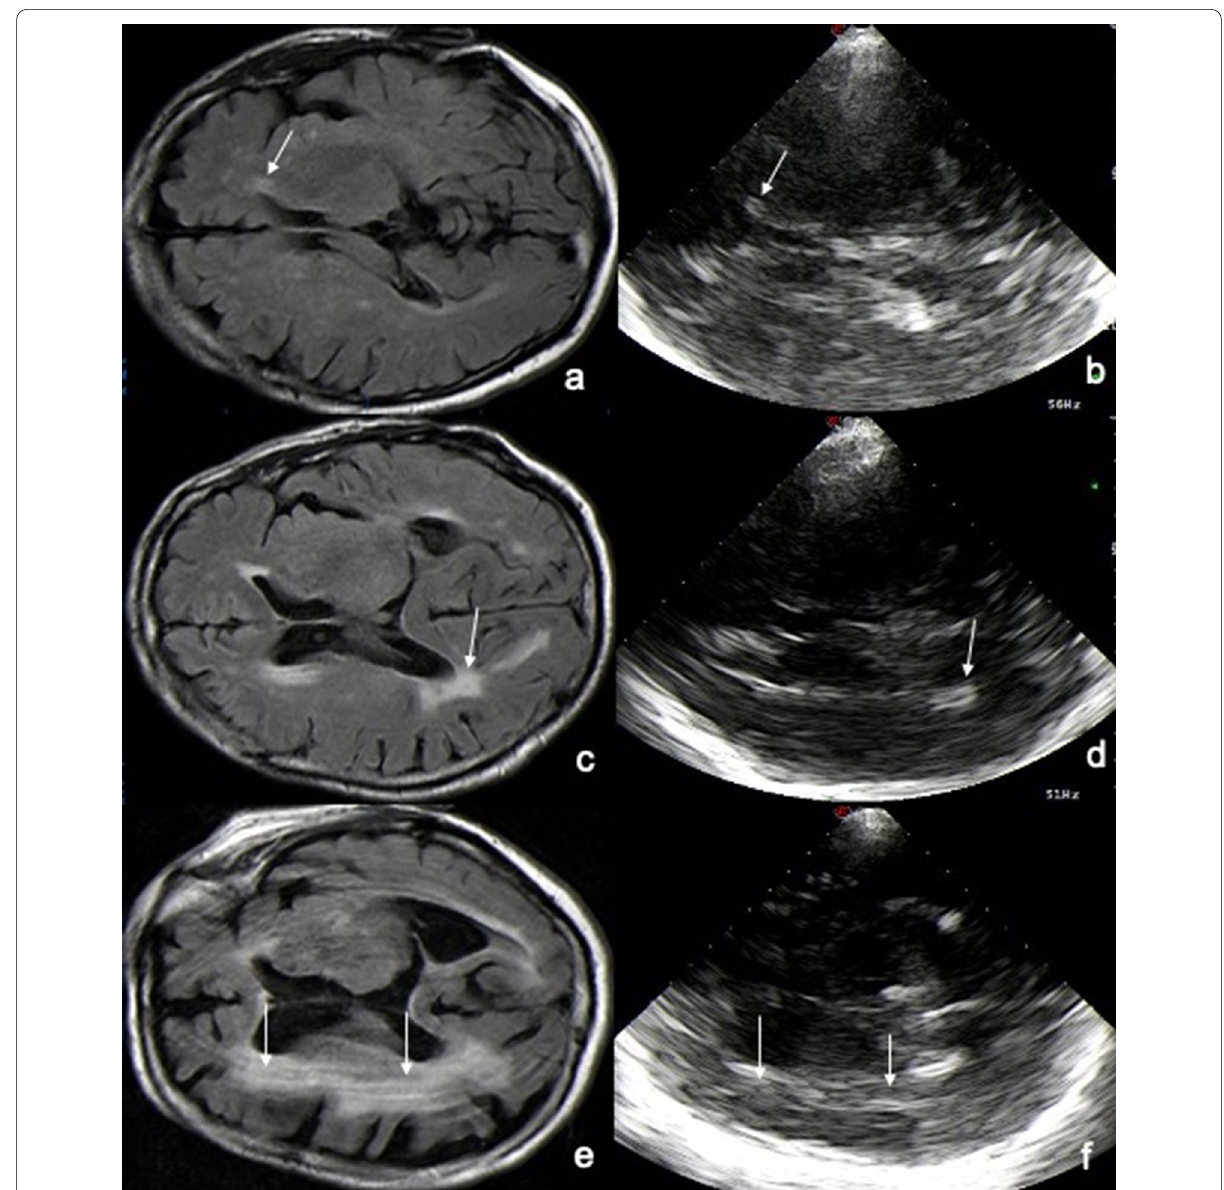
Fig. 2 US visualization of WMLs based on MRI. The brain lesions seen on MR images correspond on ultrasound (US) images to hyperechogenic signals, double or blurred lines or as inhomogeneous hyperechogenic signal surrounding the wall of the central part, the frontal or dorsal horns of the lateral ventricles. Left: cerebral MR FLAIR image, axial plane. Right: transcranial sonography in B-Mode. a , b : WMLs I, white arrows indicate WML at the anterior horn ipsilateral. c , d WMLs II, white arrows indicate WML at the dorsal horn contralateral. e , f WMLs III, white arrows indicate WML in the deep white matter surrounding the central part